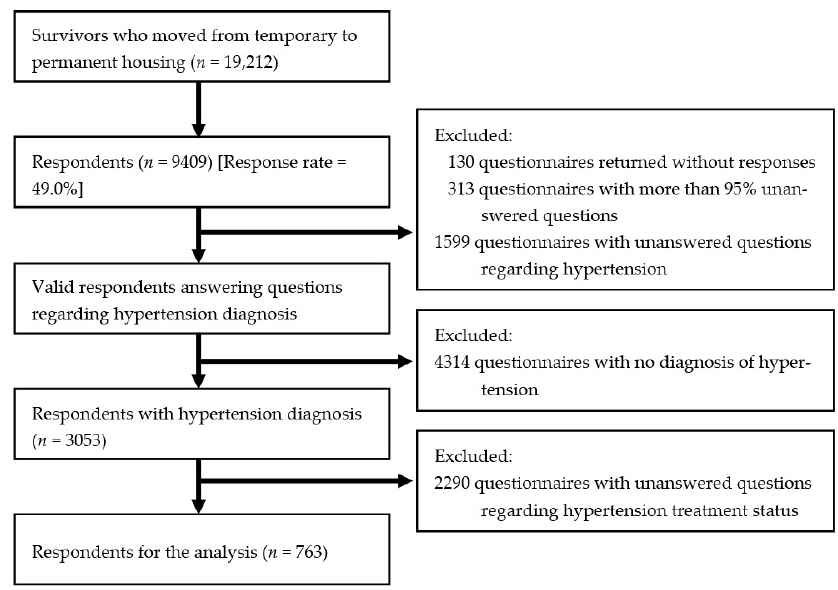
Figure 1. Flow chart summarising the number of respondents included in the analysis ( n = 763).